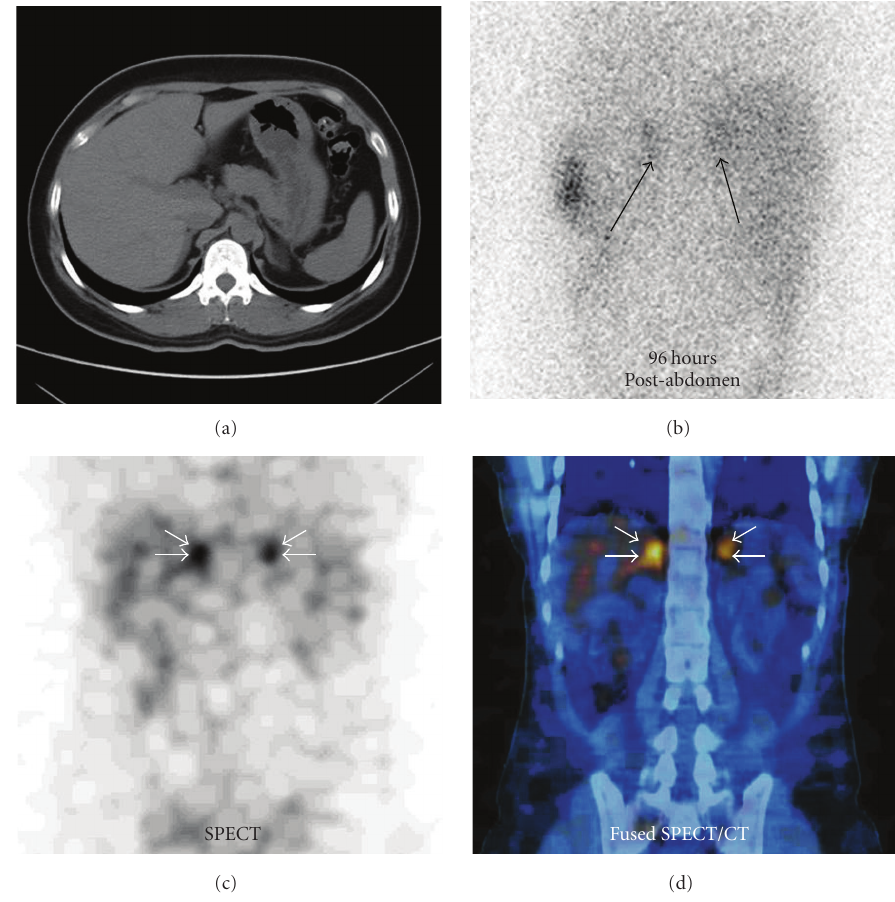
Figure 2: A 27-year-old woman (patient 15) who had stage 4 CKD presented with stage 1 hypertension alone due to bilateral adrenal hyperplasia, whose PAC was elevated, but whose serum potassium level was normal, whose PRA was nonsuppressive, whose ARR was negative, whose confirmatory testing was negative, whose bilateral adrenal lesions had normal appearing on CT (a) and faint uptakes on planar imaging (b) but true positive on SPECT (c) and coronal SPECT/CT (d) imaging. After treatment with 25 mg of spironolactone, her BP and PAC were